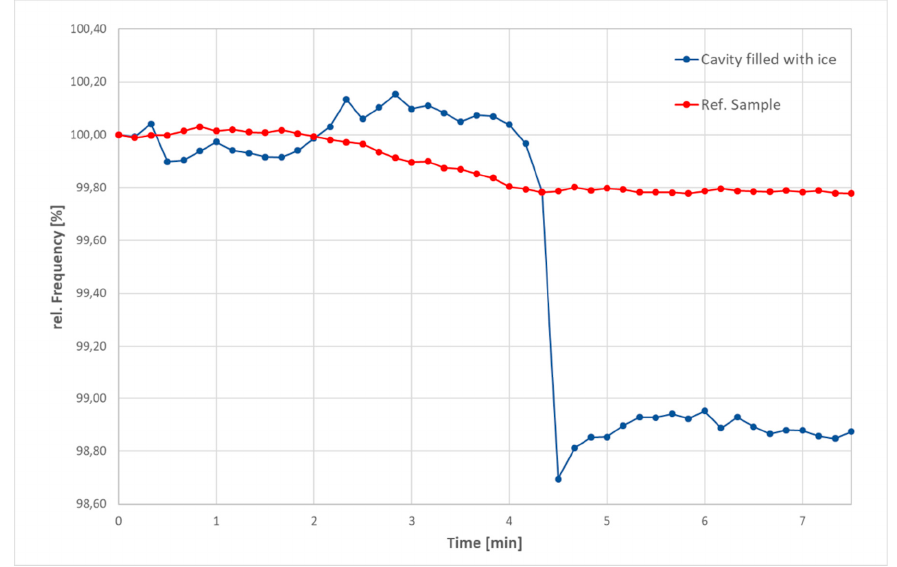
Figure 2. Relative change of frequency during melting of ice in the cavity (blue) in comparison with sample without ice (red).